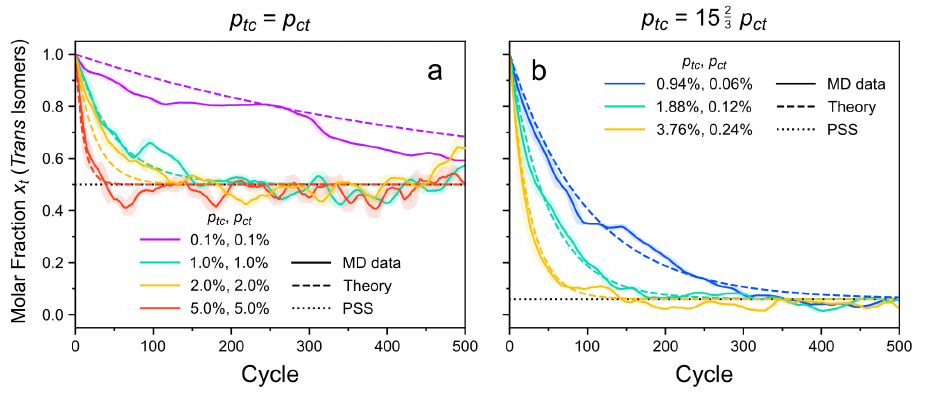
Figure 4. Molar fraction x t ( t ) of the trans isomers with respect to all azo groups as a function of time. The cis curves are omitted because x c ( t ) = 1 − x t ( t ) . ( a ) p tc = p ct . ( b ) p tc = 15 2 asymmetrical ratio of switching probabilities is inferred from previous experiments of Kind et al. [83]. Colors indicate different values of p tc and p ct . MD data are represented by solid lines. Each MD curve is smoothed via a running average (window size of 20 cycles, corresponding to 0.96ns). Shaded error bands indicate the standard deviation of the raw curve in each window. The calculated time evolution of the molar fractions is depicted as dashed lines and the respective steady-state molar fractions are shown as dotted